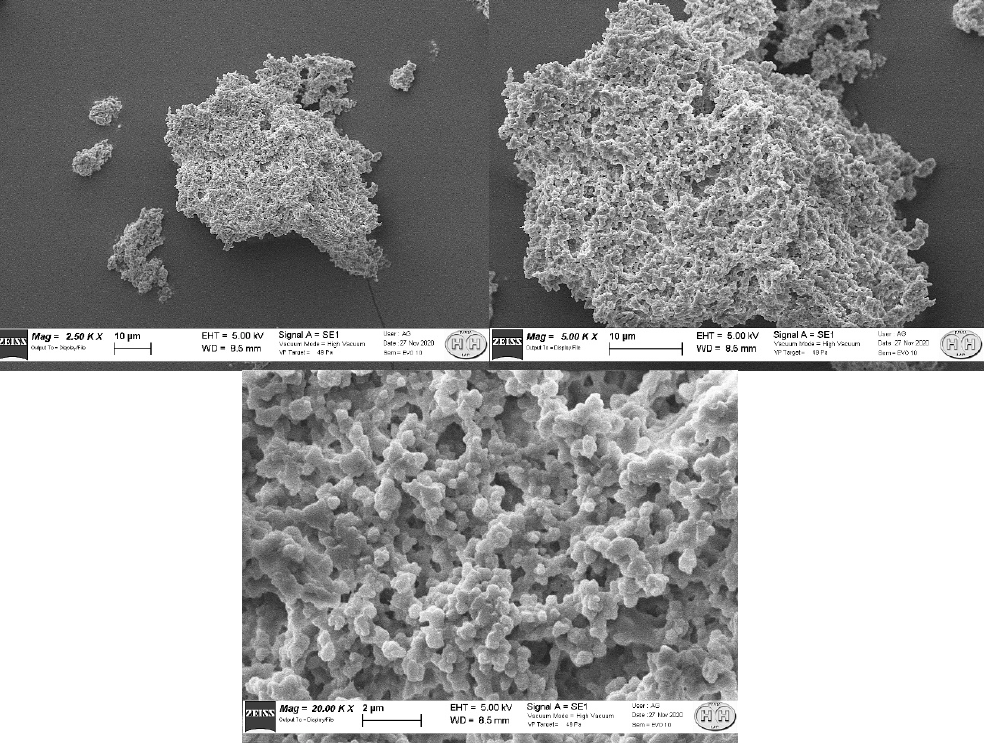
Figure 4. Successive enlargements of the second type of structure (2.50 K ×, 5.00 K ×, 20.00 K ×).3.5. [ 99m Tc]Tc-MAA and [ 68 Ga]Ga-MAA binding affinity studies.